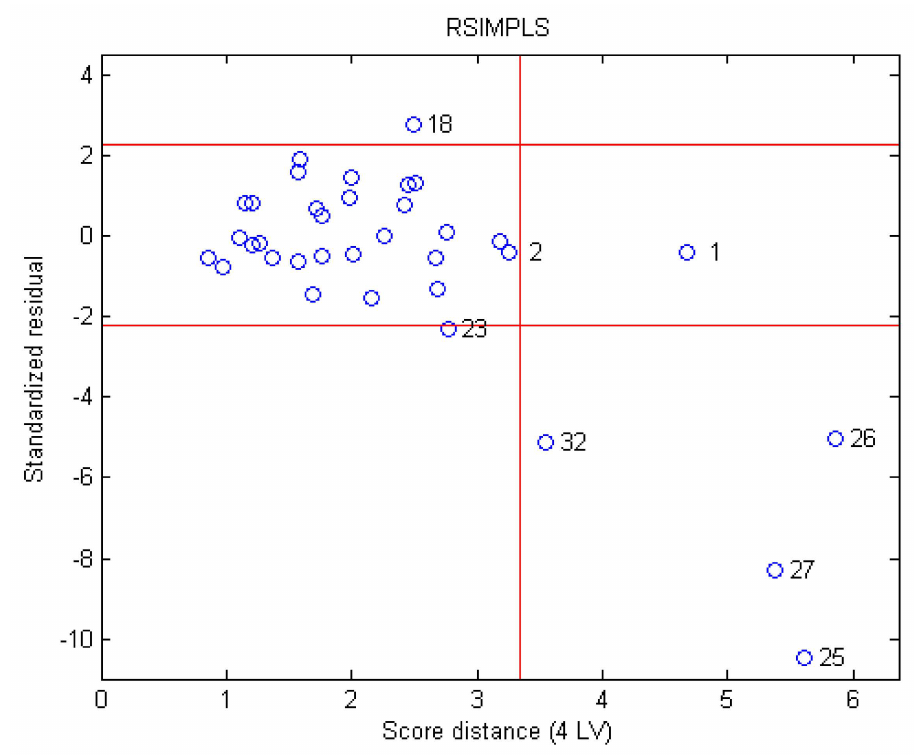
Figure 2. Distribution of all the samples in the space spanned by Standardized residual and Score